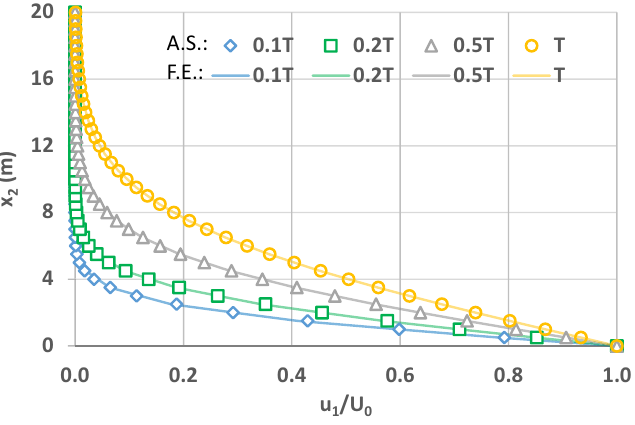
Figure 4. Velocity profiles of x 1 direction velocity u 1 normalized by boundary velocity U 0 when space and time fractional derivative powers are 1. Solid lines correspond to simulations by fractional governing equation (F.E.) when time t = 0.1 T, 0.2 T, 0.5 T¸ T. Shapes (diamond, square, triangle, and circle) represent the corresponding analytical solutions (A.S.) of the conventional governing equation,